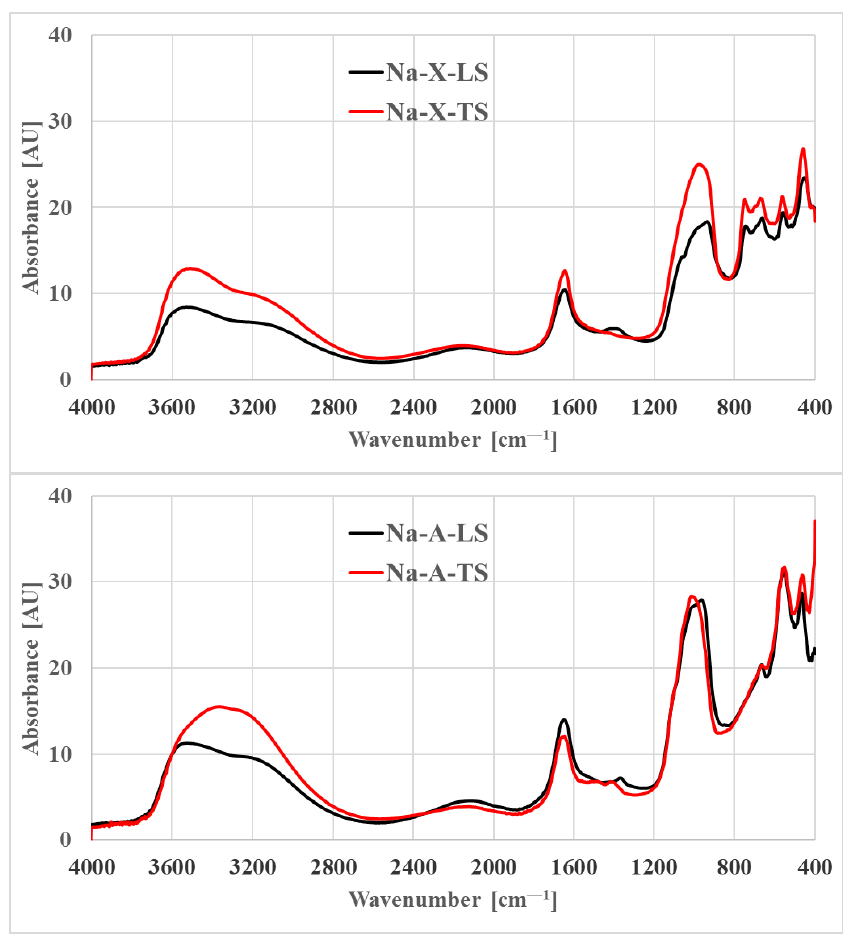
Figure 8. FT-IR spectra of investigated zeolites. For Na-X-LS, a small band originating from carbonate vibrations was recorded at 1394 cm − 1 . The Na-X-TS did not show the presence of this band. On the other hand, it was present in both Na-A materials at 1377 cm − 1 . The bands in the range of about 1090–900 cm − 1 are related to the asymmetric stretching vibrations of the Si-O(Al) and Si-O(Si) bridges. For the materials obtained in the laboratory scale, the maxima of these bands were slightly shifted towards lower wavenumbers and additional band around 920 cm − 1 can be distinguished. The spectra for TS and LS materials indicate the possibility of differences in the Si/Al ratio in zeolites resulted from the process scale applied. The amount and a type of exchangeable cations can also be considered, which may affect the nature of the registered bands [52]. For Na-A, the band at 667 cm − 1 is related to the symmetric stretching vibrations of the Si-O-Al bridges. The band at 556 cm − 1 can be attributed to the symmetric Si-O-Si stretching and O-Si-O bending vibrations of the LTA 4-member ring [53]. For Na-X in the pseudolattice range, three distinct groups of bands can be distinguished. The first one in the range 740–690 cm − 1 , can be attributed to symmetric stretching vibrations of the four-member ring. These vibrations are accompanied by vibrations of the six-member ring, which are located at slightly lower wave numbers (670–560 cm − 1 ). The third group of bands, with a maximum at 459 cm − 1 is associated with O-Si(Al)-O bending vibrations of six-membered rings in D6R units or possibly with vibrations of higher-membered (12-membered) rings. For Na-X, the bands at 468 cm − 1 are derived from O-Si-O bending